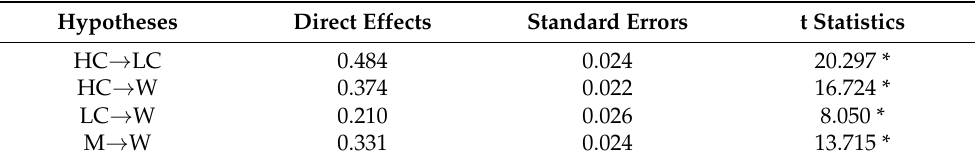
Table 2. Hypothesis test for direct effects between latent